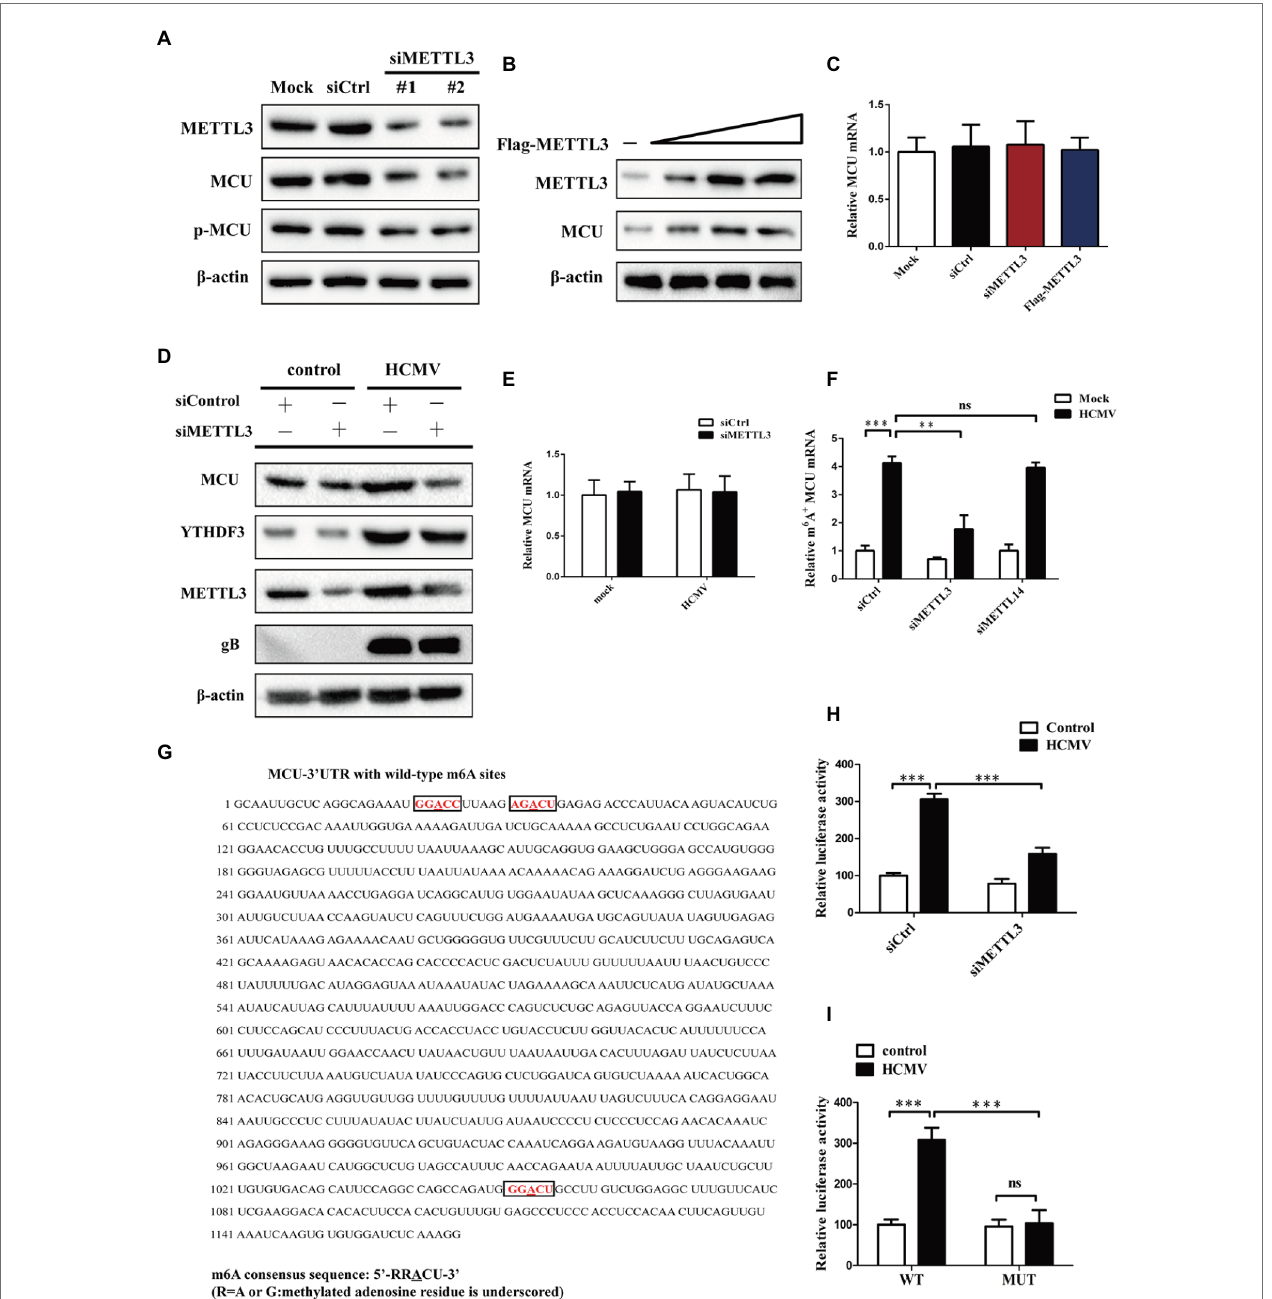
FIGURE 5 | METTL3 upregulates MCU protein expression (but not mRNA) by catalyzing its m6A methylation in mock-infected or HCMV-infected HAECs. (A) Western blot analysis of MCU protein levels after knockdown of METTL3 in mock-infected HAECs. (B) Western blot analysis of MCU protein levels after overexpression of METTL3 in mock-infected HAECs. HAECs were transfected with a different dose of METTL3 expression plasmids and then subjected to immunoblot. (C) qRT-PCR analysis to quantify the relative MCU mRNA level after knockdown or overexpression of METTL3 in mock-infected HAECs. (D) Western blot analysis of MCU protein level after METTL3 knockdown in HCMV-infected HAECs. (E) qRT-PCR analysis to quantify the relative MCU mRNA level after knockdown of METTL3 in HCMV-infected HAECs. (F) m6A immunoprecipitation and qRT-PCR were performed to determine the change of MCU mRNA with m6A methylation. HAECs with or without knockdown of METTL3 or METTL14 were exposed to HCMV. (G) Sequence analysis of the MCU 3 ′ -UTR revealed three matches to the 5 ′ -RRACU-3 ′ (underlined are methylated adenosine residue) m6A consensus sequence. (H) Luciferase assays were performed by transfecting HAECs with a reporter plasmid containing luciferase coding sequences followed by the MCU 3 ′ -UTR or empty vector only containing luciferase. The ratio indicating the luciferase activity in cells transfected with MCU 3 ′ -UTR relative to empty vector was determined. (I) Luciferase assays were performed in HAECs transfected with WT or mutant (MUT) luciferase-MCU 3 ′ -UTR reporters. The ratio of luciferase activity in cells transfected with MCU-3 ′ UTR relative to empty vector was determined. All data are expressed as the mean ± SD of triplicate experiments. Student’s t- test, ** p < 0.01 and *** p < 0.001. ns: no significant